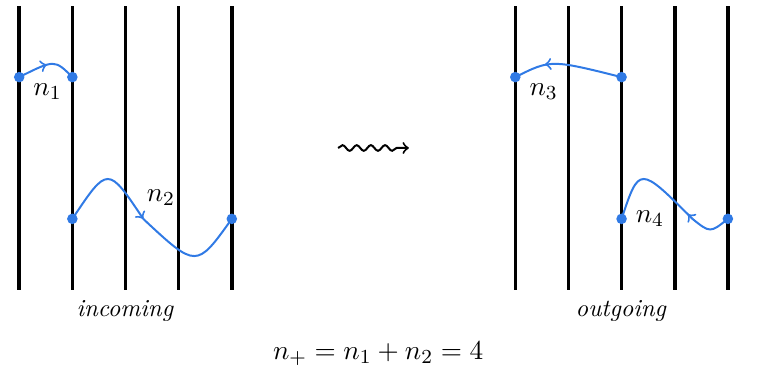
Figure 3. A four-point open string amplitude with n 1 = 1 , n 2 = 3 , n 3 = − 2 , and n 4 = − 2 . Open strings can only join or split at the same D-brane. There is a total of n + + 1 = 5 D-branes for this choice of closed string quantum